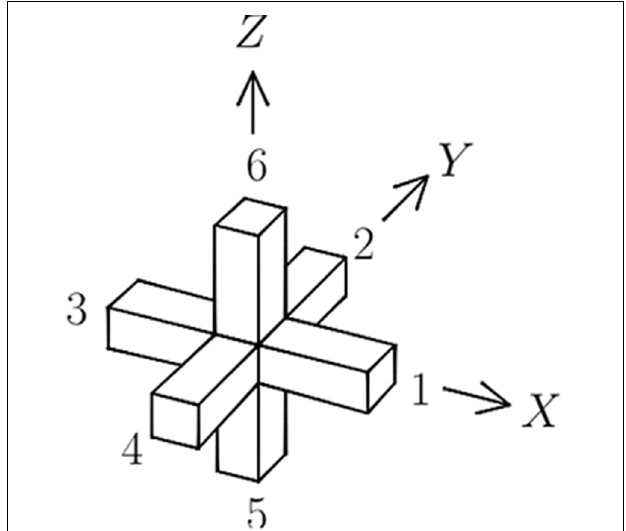
FIGURE 1 | Enumeration scheme on the beams of a cube lattice connecting node i to its j = 1–6 nearest neighbors, showing the coordinate system with i as its